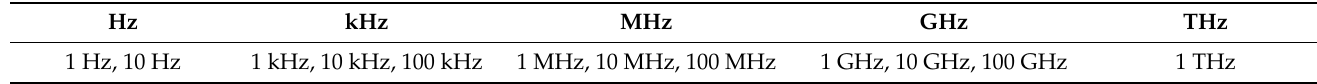
Table 1. Full frequency band